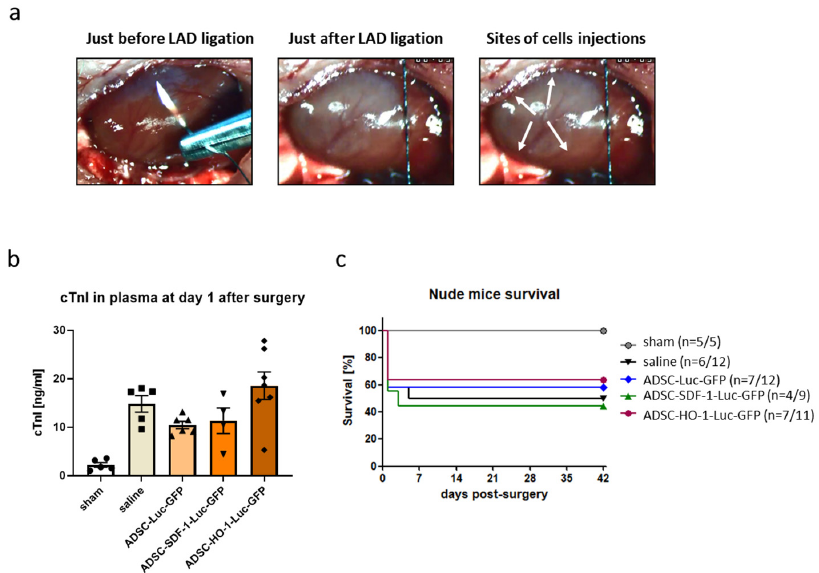
Figure 2. Induction of myocardial infarction (MI) in athymic Nude mice. ( a ) Schematic representation of murine heart subjected to MI. Arrows indicate the site of ADSC injections. ( b ) Level of cTnI in plasma of mice subjected to surgery and cell administration confirming successful MI induction. N = 4–7 animals/group. ( c ) Kaplan–Meier survival curves for Nude mice subjected to MI and cell administration. Sham-treated animals served as a control. N = 4–7 animals/group (numbers in parentheses represent surviving mice/all mice used).